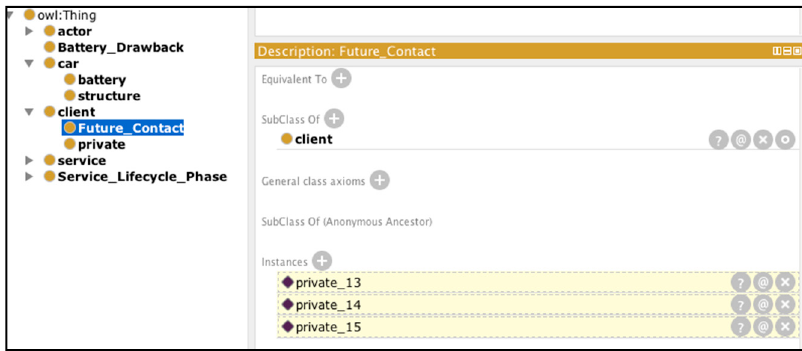
Figure 19. Inferred knowledge on the customer to contact in the near future.